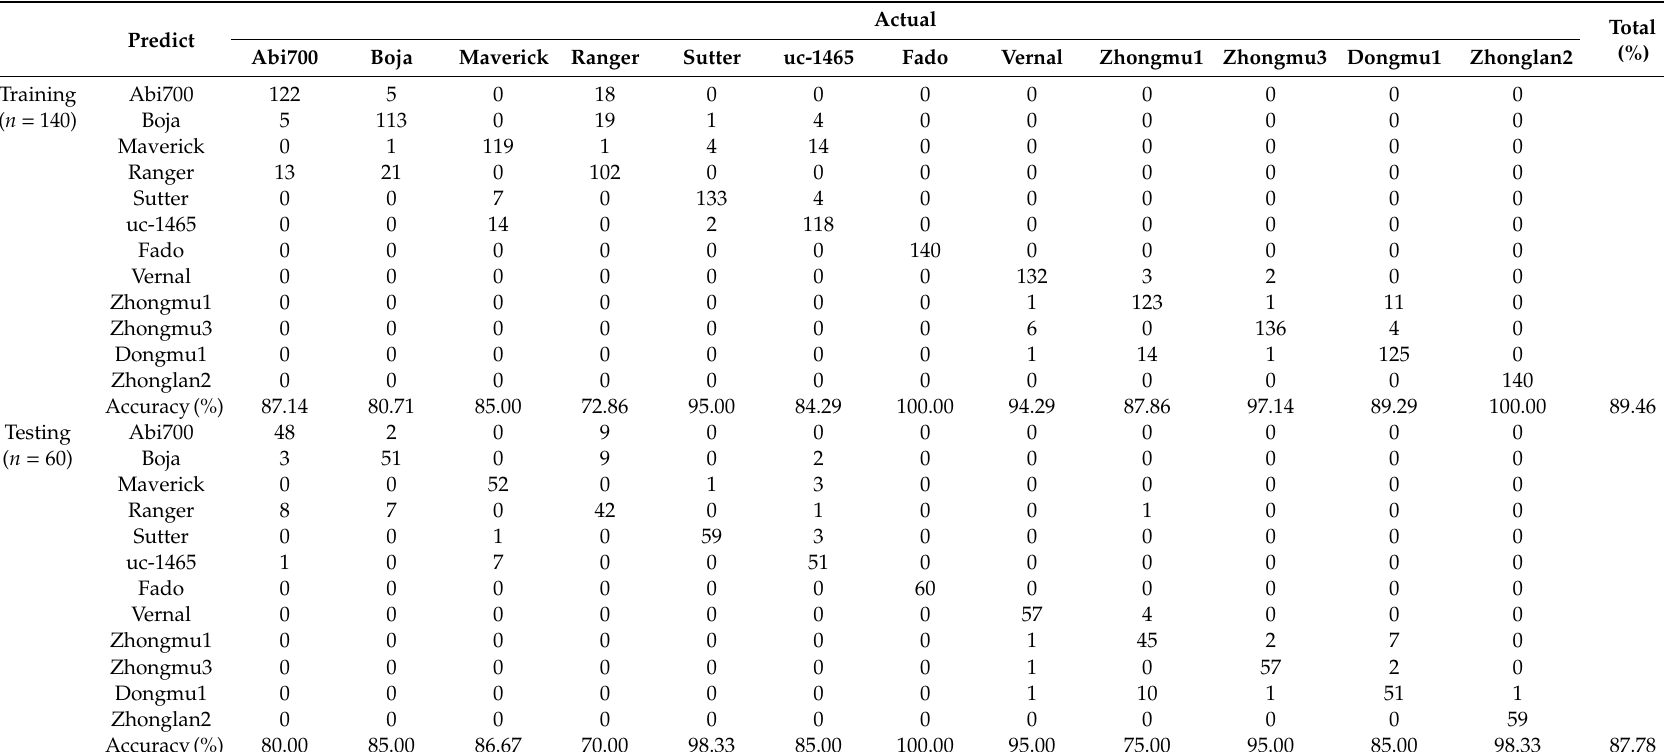
Table 3. Discrimination performance based on SVM with spectral of 12 Medicago sativa L.